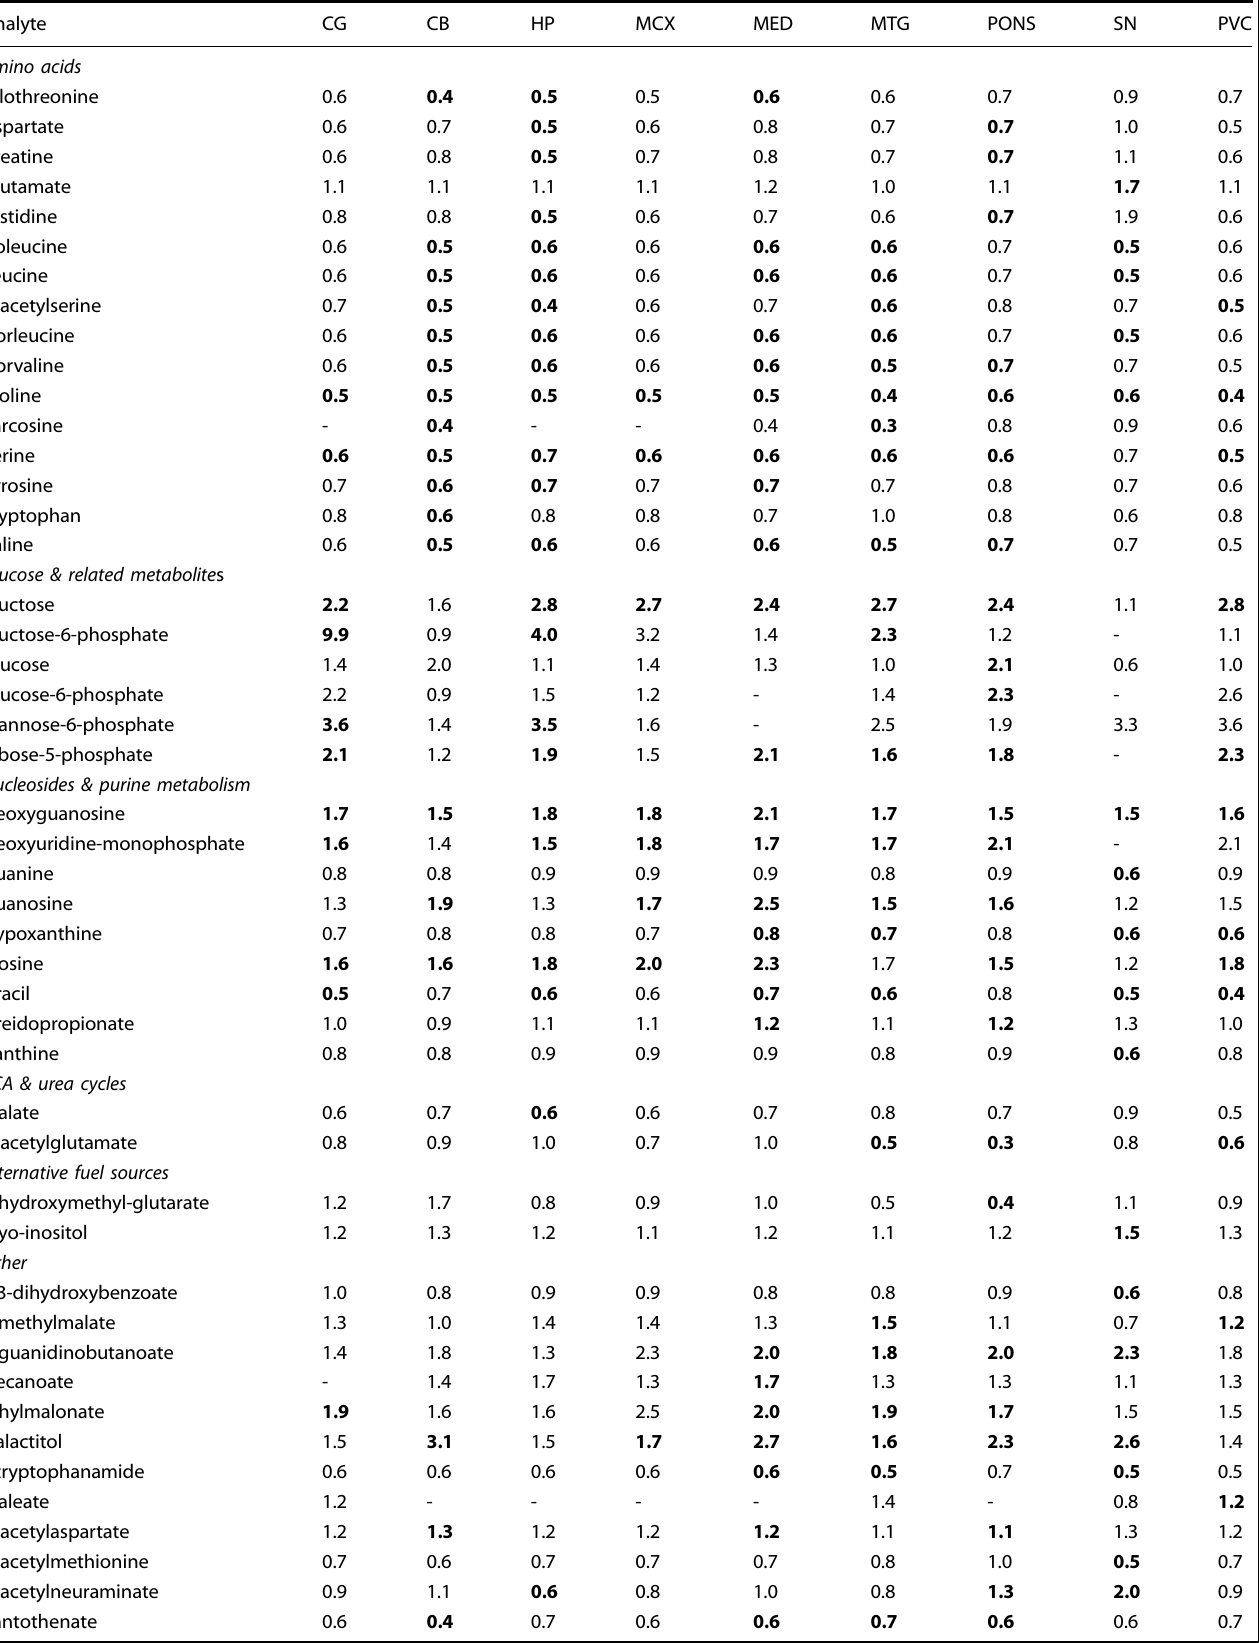
Table 1. Signi fi cantly altered metabolites in the PDD brain.